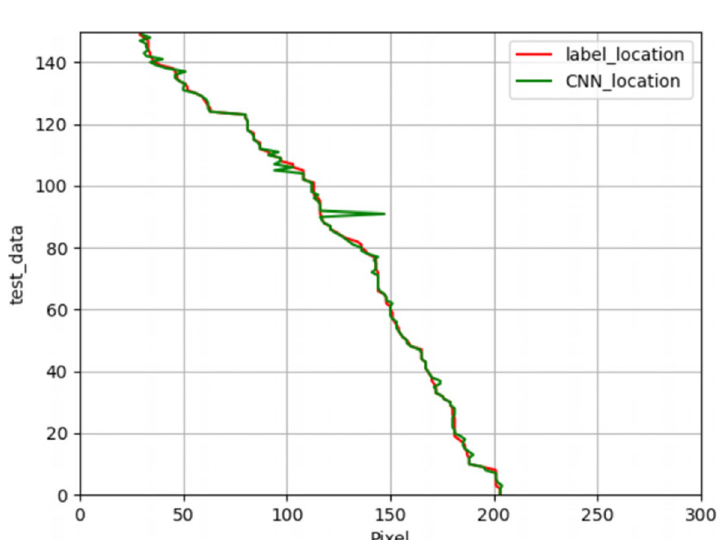
Fig. 12 Comparison of leading edge position between reconstructed flow field image and CFD leading edge